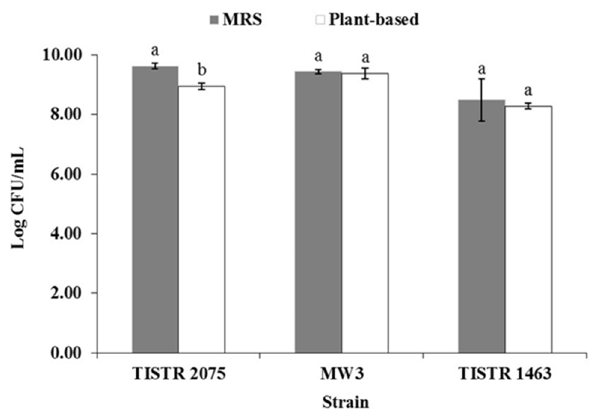
Figure 1. Growth of LAB in MRS and plant-based media after 24 h of incubation. Each color is the average of three replicates. Different superscripts for each strain indicate significant difference ( p < 0.05).